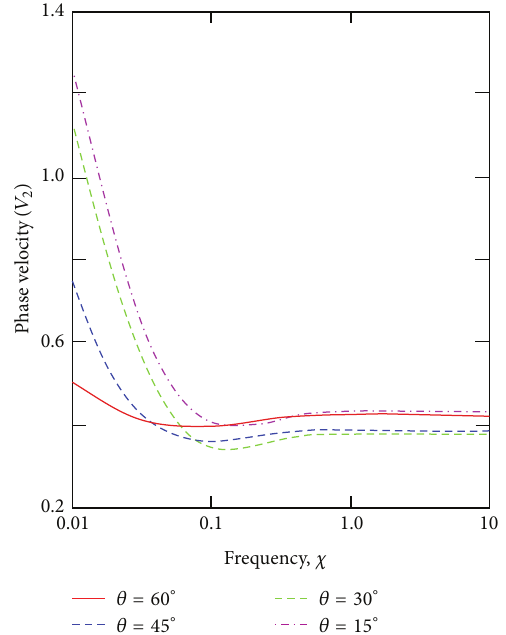
Figure 2: Variation of QT wave velocity with nondimensional frequency in various direction of propagation.